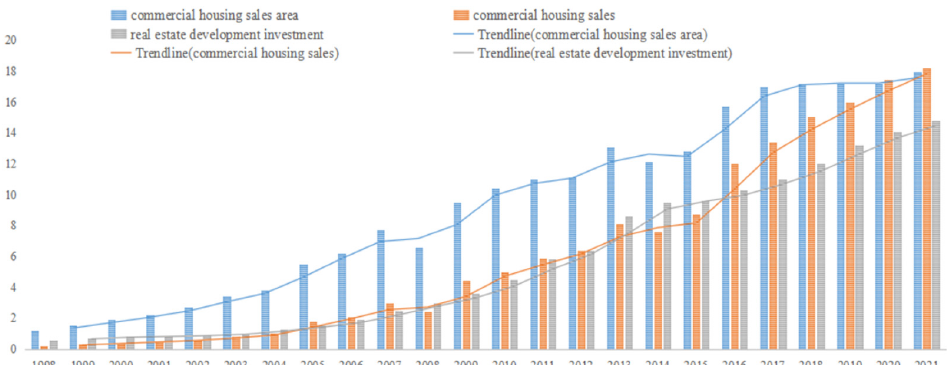
Figure 1. National real estate development trends 1998–2021. Data source: National Bureau of Statistics; CREIS CMI.